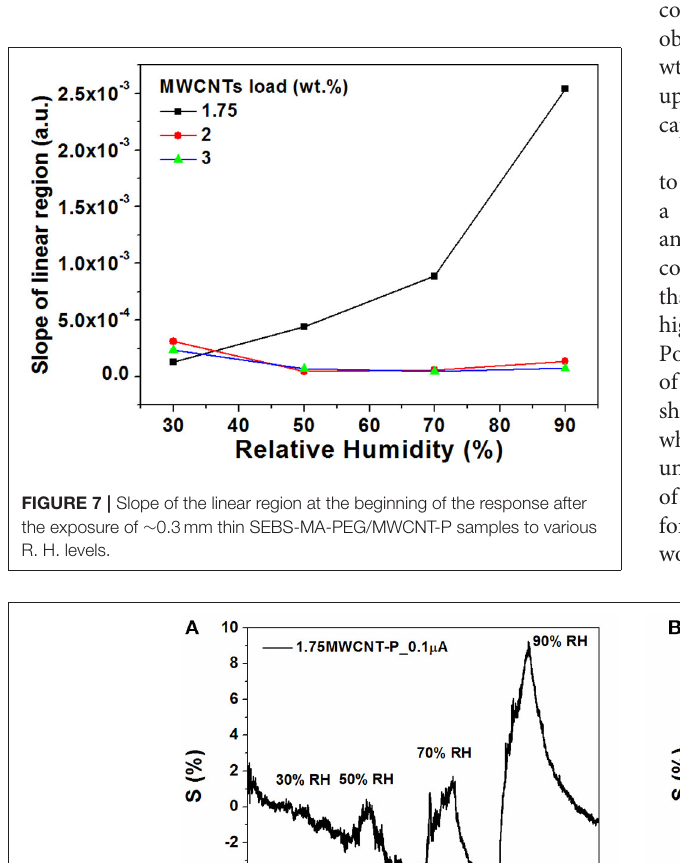
FIGURE 8 | Cyclic sensing measurements with different source currents using thin samples ( SEBS-MA-PEG/2MWCNT-P.